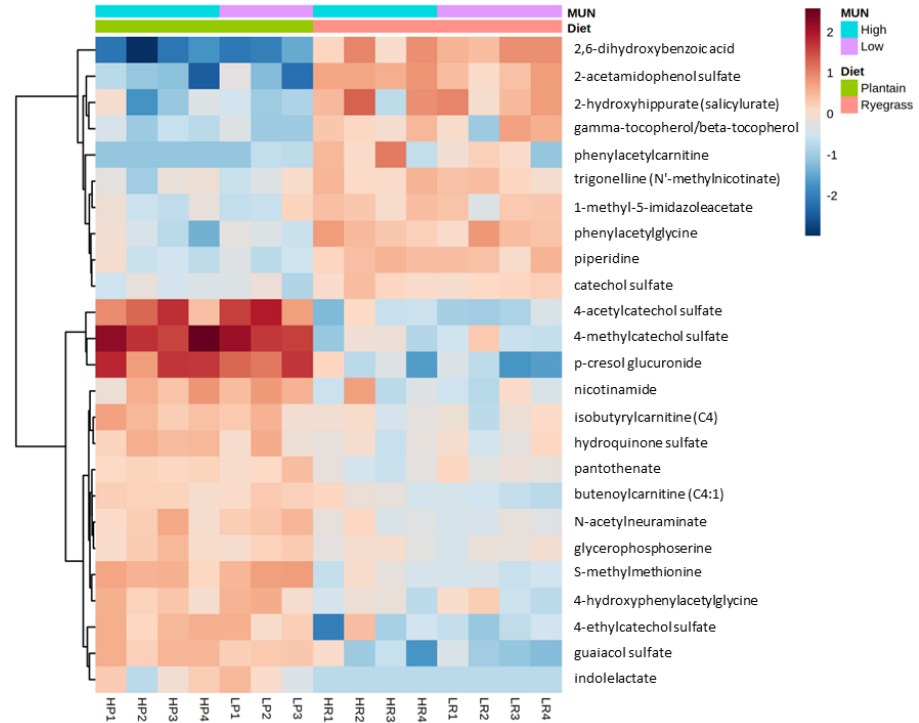
Figure 1. Heatmap of the top 25 metabolites detected in cows milk clustered by a Wards clustering algorithm that are considered statistically different ( p < 0.05) based on a linear model where diet (plan- tain or ryegrass) was considered the primary factor and animal genetics (milk urea nitrogen breeding values) was considered a covariate. A red colour indicates a higher abundance of the corresponding metabolite and a blue colour indicates a lower abundance of the corresponding metabolite.